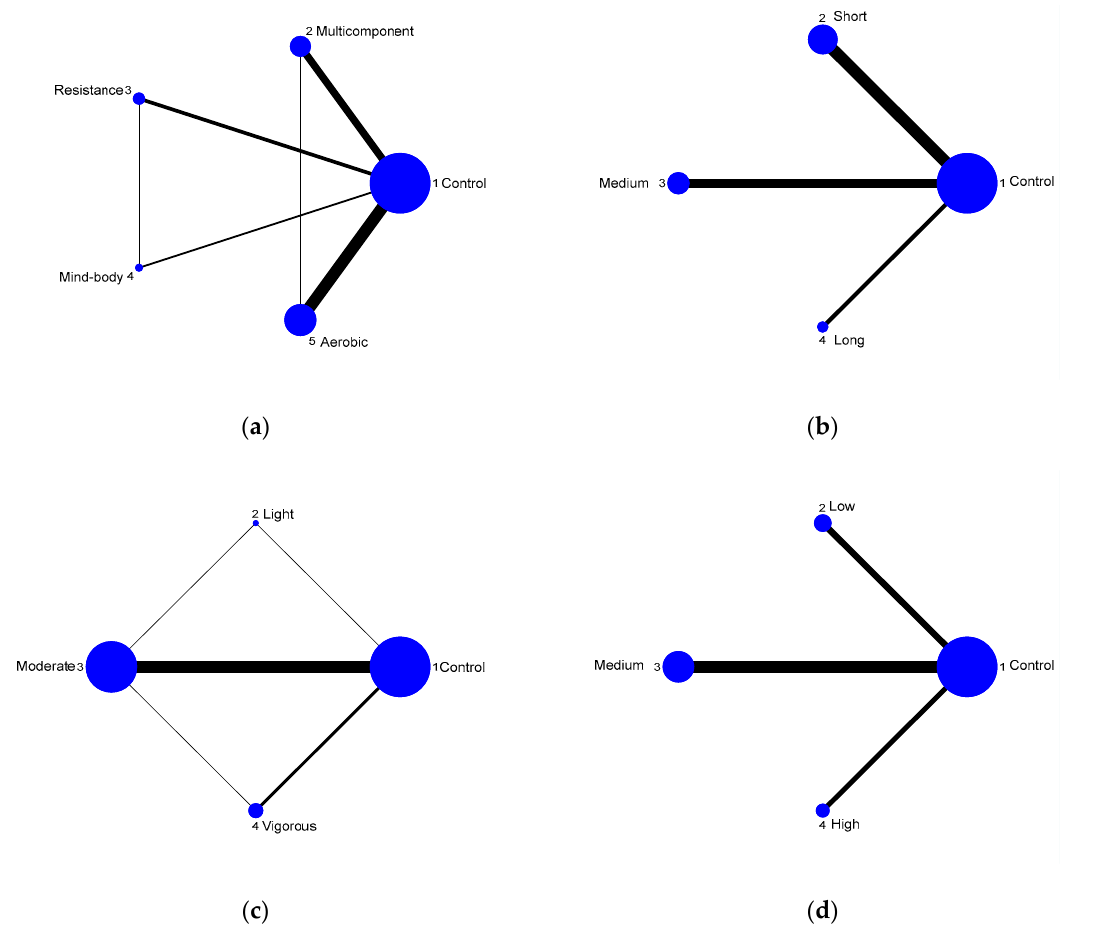
Figure 3. NMA maps of the studies examining the efficacy of exercise in people living with CI on global cognition. ( a ) exercise type; ( b ) exercise time; ( c ) exercise intensity; ( d ) exercise Table 3. Ranking table of exercise moderators.